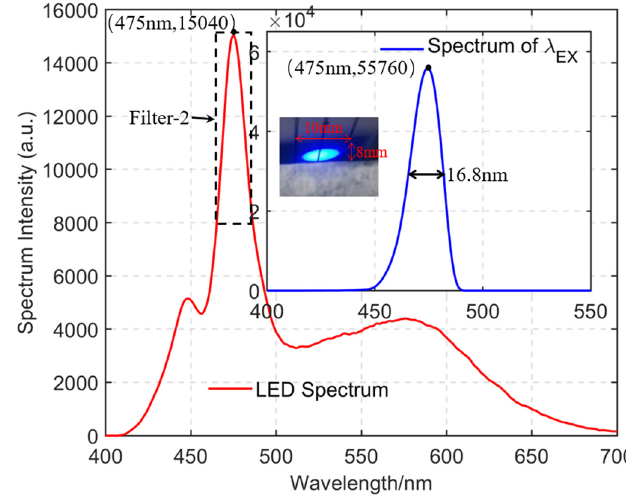
Figure 3. Spectral features of the LED and excitation light spot.